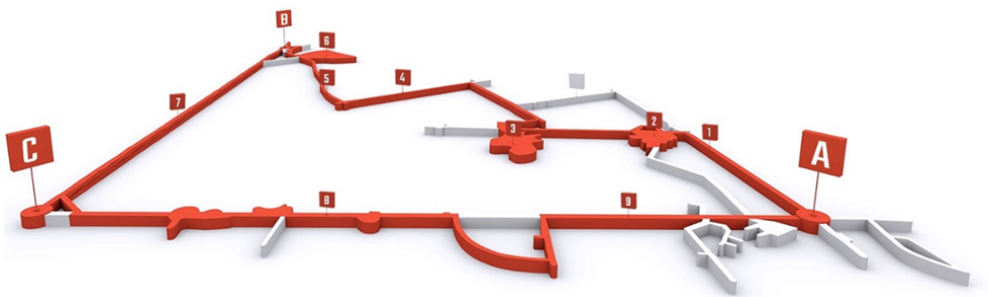
Figure 1. Tourist route in the Historic Silver Mine (A—“Anioł” shaft: B—“Szcz˛e´s´c Bo˙ze” shaft; C—“ ˙Zmija” shaft; 1—“Staszic” gallery; 2—“Srebrna” chamber; 3—"Zawałowa” chamber; 4—“Niski” gallery; 5—“Wysoki” gallery; 6—“Niska” chamber; 7—water gallery (boat flow); 8—“Okr˛e ˙ zny” gallery; 9—“Garus”